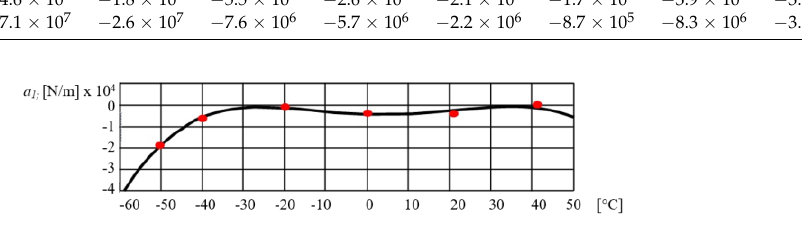
Figure 7. Dependence of a 1 of temperature.